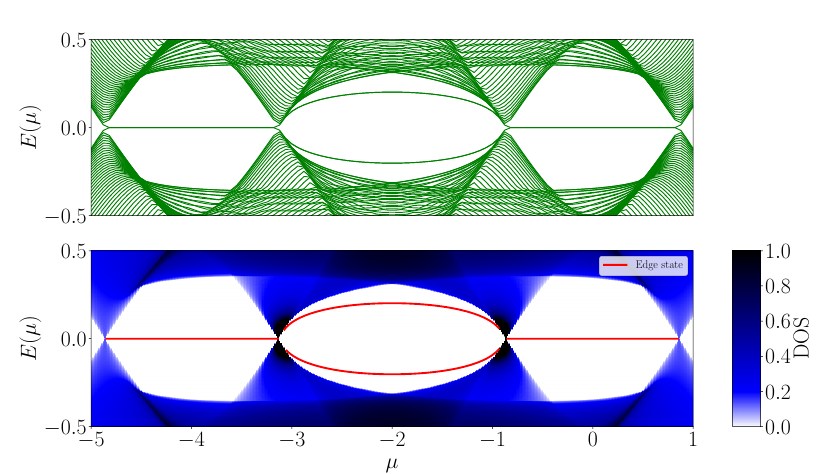
Figure 7: Spectrum of a superconducting nanowire as a function of chemical potential µ . Upper panel, the eigenvalues of a finite wire of 100 sites obtained using direct diagonalization. Lower panel, color plot of the local DOS (blue) together with the bound states calculated directly in the thermodynamic limit (red lines). The Hamiltonian is given in Eq. (24) with = 0.5 and ∆ = B = 1, t = − 1, α so